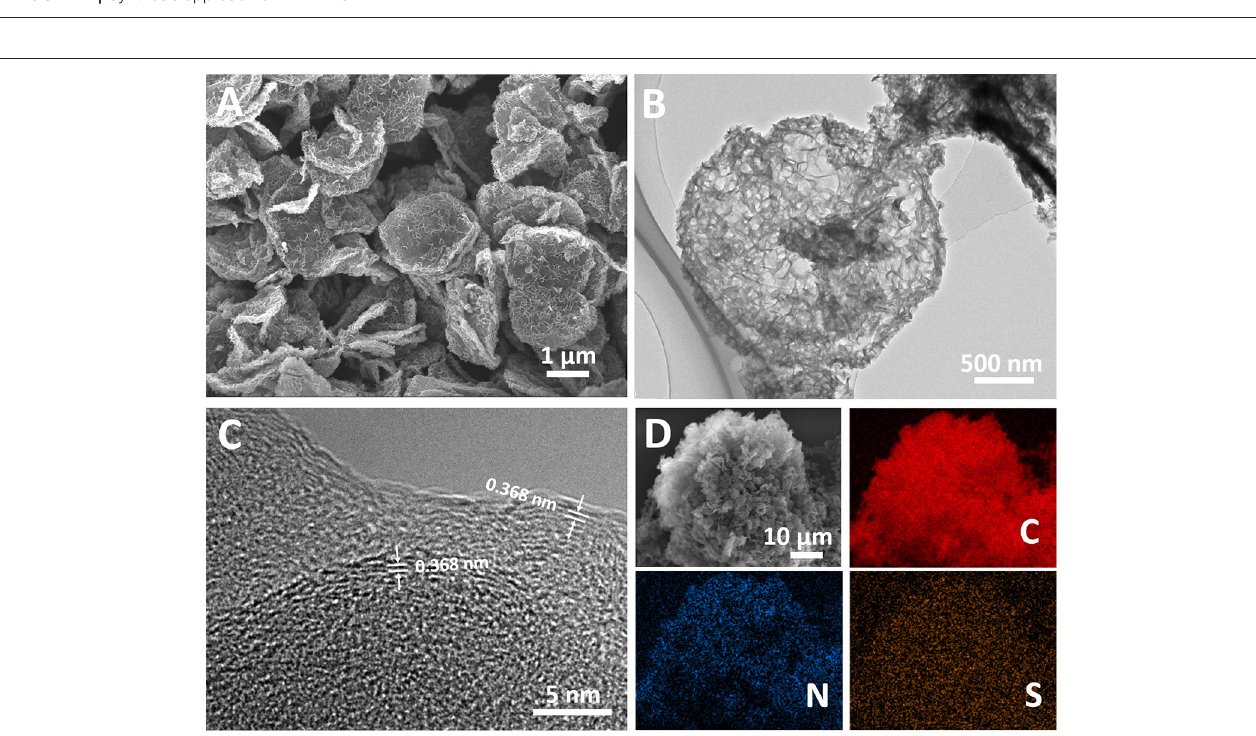
FIGURE 2 | (A) Scanning electron microscopy image of H-2D-HCA; (B) Transmission electron microscopy image of H-2D-HCA; (C) HRTEM image of H-2D-HCA; (D) SEM elemental mapping of H-2D-HCA. at 284.4 eV can be attributed to C-C/C = C of carbon; and the peak located at 285.1 eV reveal the presence of C-N and C-S